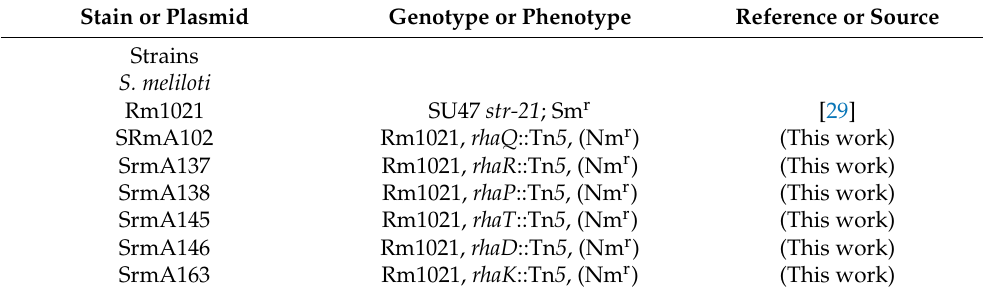
Table 1. Strains and